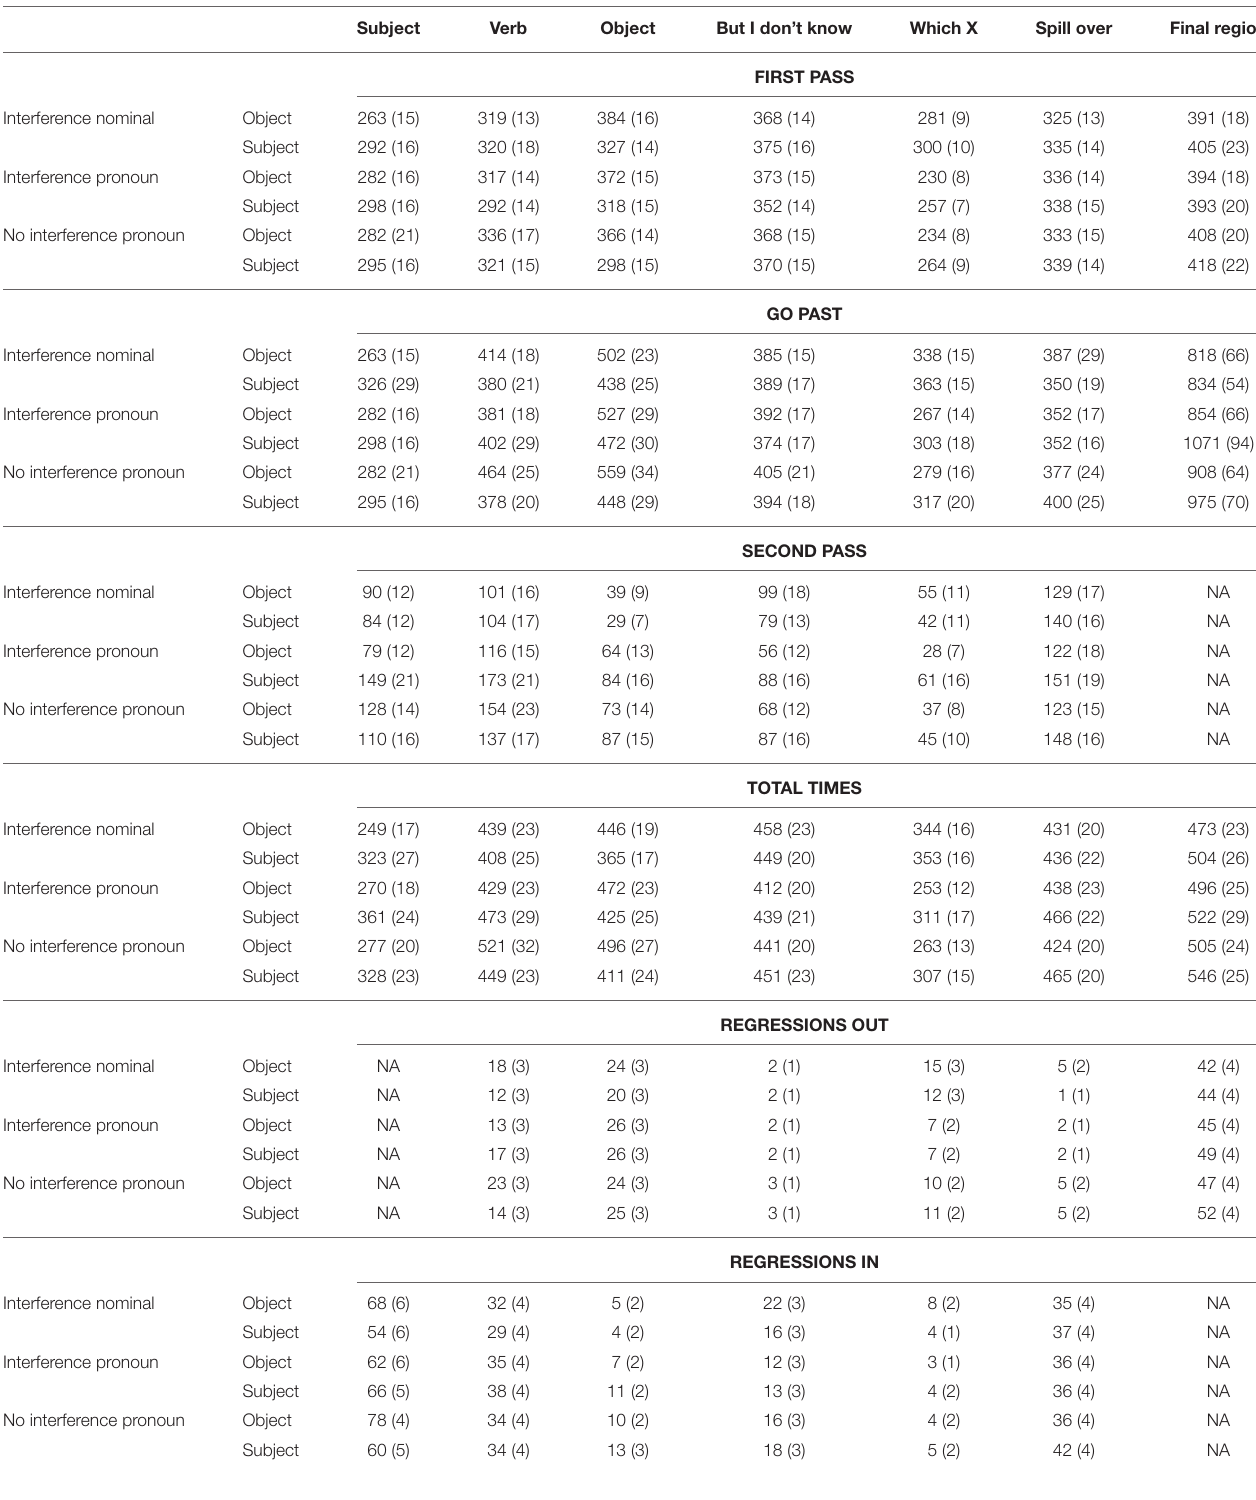
TABLE 5 | Experiment 2: means and standard deviations for all eye tracking measures. Subject Verb Object But I don’t know Which X Spill over Final